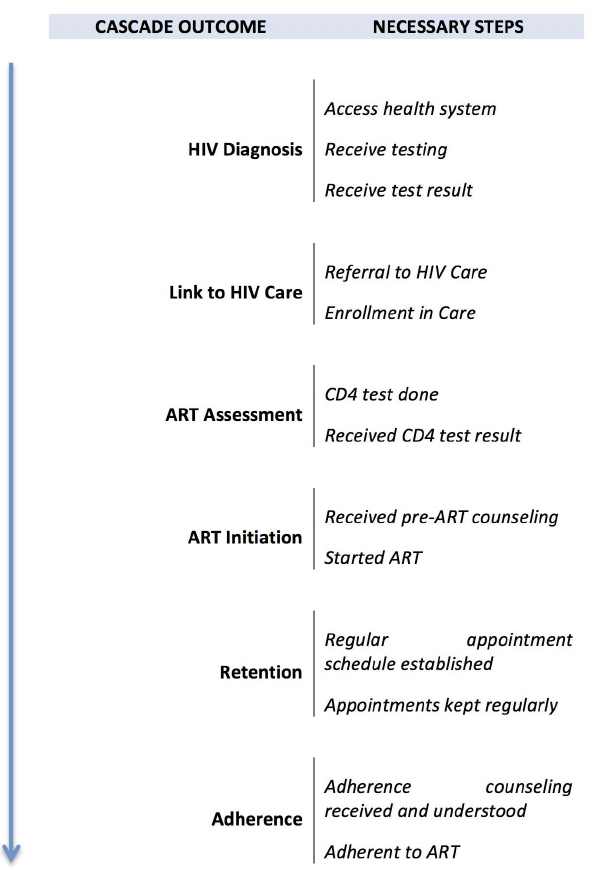
Figure 2. The Maternal ART Cascade.